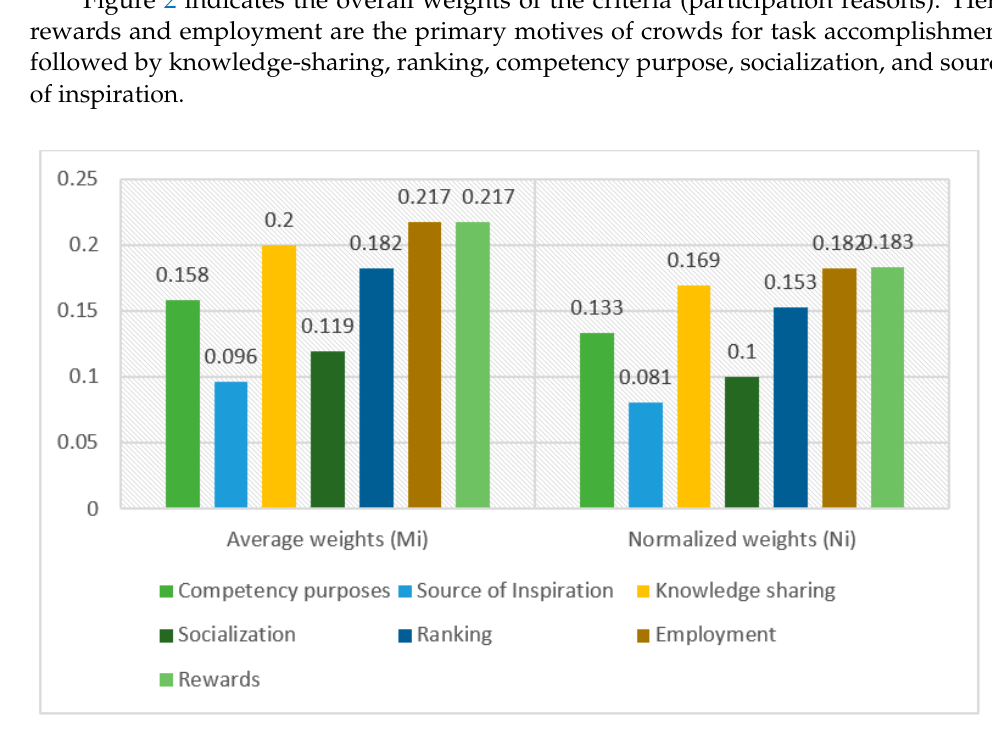
Figure 2 . Average and normalized weights of criteria . Figure 2. Average and normalized weights of